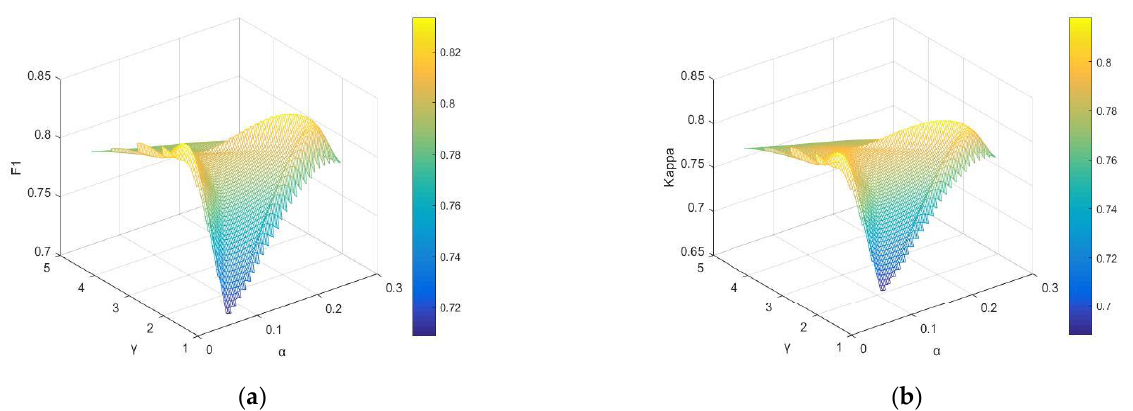
( b ) Figure 8. Triangular surface maps of F1 and Kappa on the verification sets: ( a ) F1-score of verifica- tion set 4; and ( b ) Kappa coefficient of verification set 4. From the above Figure, a higher brightness of yellow means a higher accuracy. In verification sets 1, 3 and 4, the yellow highlights are concentrated within 0 < α < 0.1 and 1 < γ < 3, which shows that the two parameters have the highest accuracy within these two intervals. In verification set 2, the yellow highlights are concentrated within 0 < α < 0.1, 1 < γ < 3 and 0.2 < α < 0.3, 1 < γ < 3. However, from Table 4, when 0 < α < 0.1 and 1 < γ < 3, the F1-score and Kappa coefficient are both higher than 0.2 < α < 0.4. From the trend of accuracy change in the above Figs., the two parameters are not linearly related to accuracy. Therefore, the regression algorithm uses multiple logistic re- gression analysis. In this multiple regression analysis, parameters α and γ are independ- ent variables, and the F1-score and Kappa coefficient are dependent variables. The specific analysis results are shown in Table 5. Table 5. Multivariate logistic regression analysis of two parameters and their accuracy on the four verification sets. Parameter